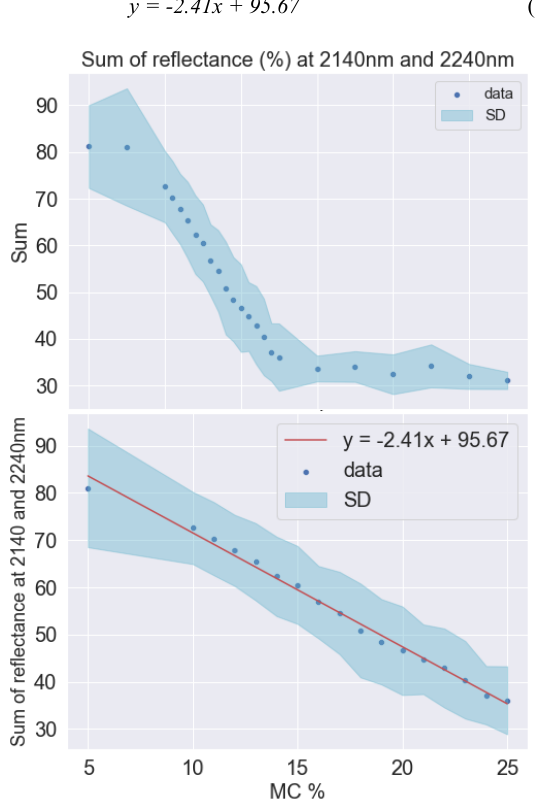
Figure 5(a & b). There is a linear relationship between the sum of soil reflectance at 2140 & 2240nm and MC between 5 and 25%